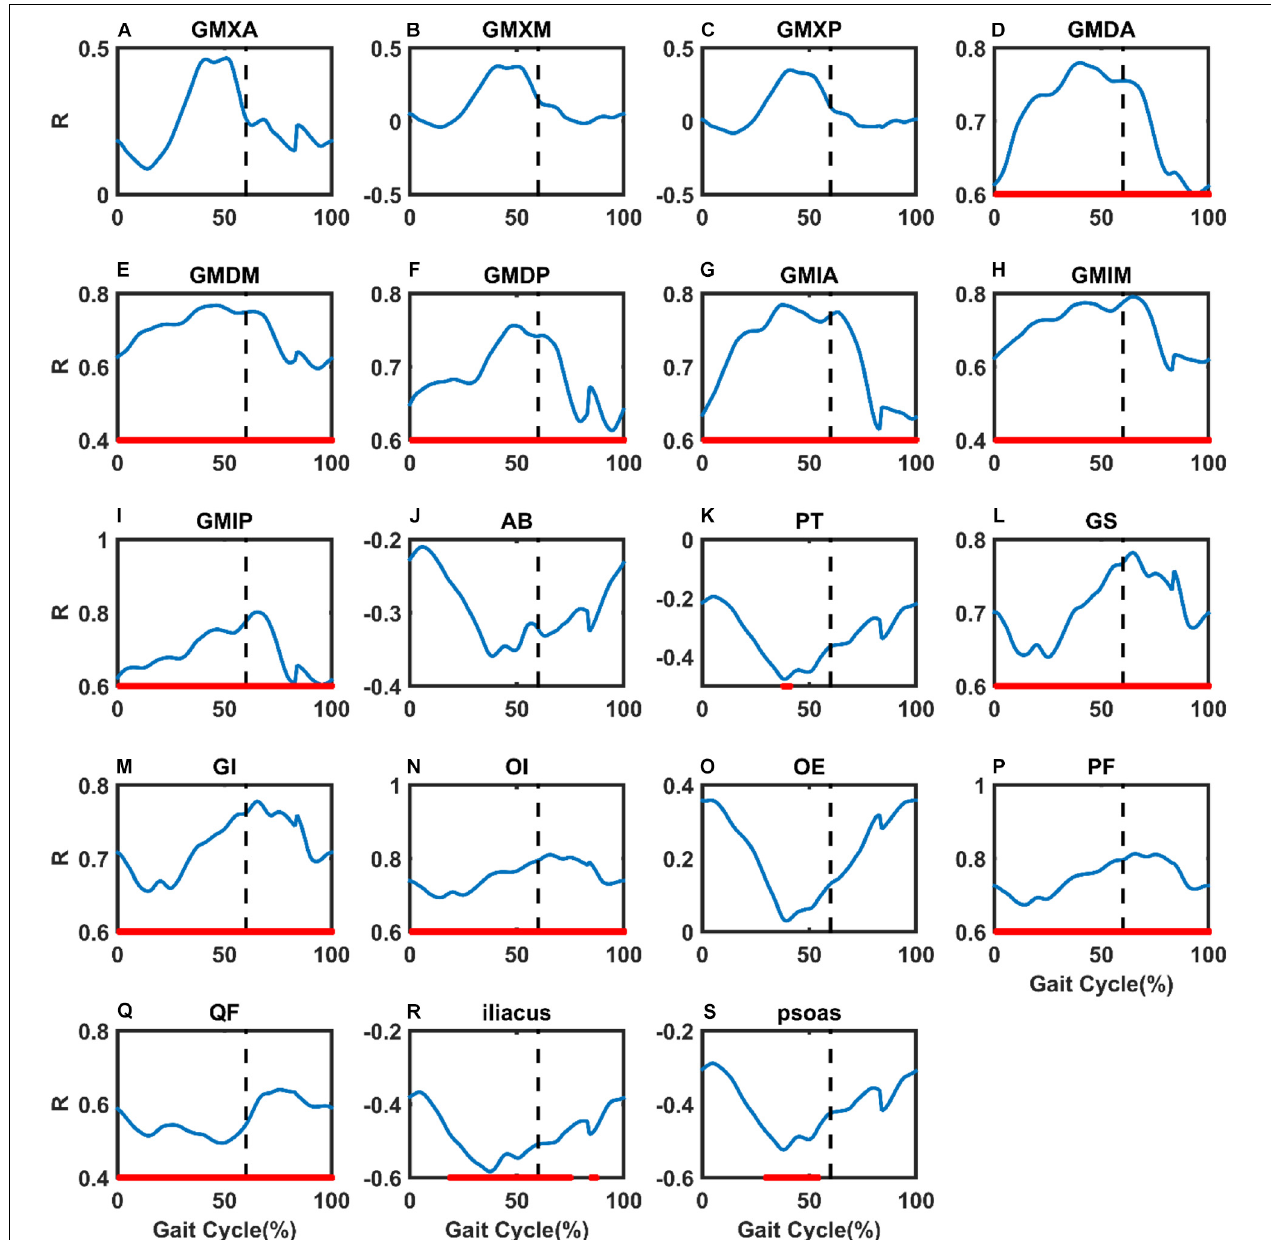
FIGURE 3 | The changes in the correlation coefficient (R) between FO difference and hip muscle moment arm difference compared with non-implanted hip in THA patients were illustrated during gait. (A) Gluteus maximus anterior bundle (GMXA), (B) gluteus maximus median bundle (GMXM), (C) gluteus maximus posterior bundle (GMXP), (D) gluteus medius anterior bundle (GMDA), (E) gluteus medius median bundle (GMDM), (F) gluteus medius posterior bundle (GMDP), (G) gluteus minimus anterior bundle (GMIA), (H) gluteus minimus median bundle (GMIM), (I) gluteus minimus posterior bundle (GMIP), (J) adductor brevis (AB), (K) pectineus (PT), (L) gemellus superior (GS), (M) gemellus inferior (GI), (N) obturator internus (OI), (O) obturator externus (OE), (P) piriformis (PF), (Q) quadratus femoris (QF), (R) iliacus, and (S) psoas. Nearly 60% of the black vertical dashed lines indicate toe-off. Areas of statistical significance were represented by the bold red line along the X -axis of each graph. X -axis: percentage of the gait cycle, Y -axis: R